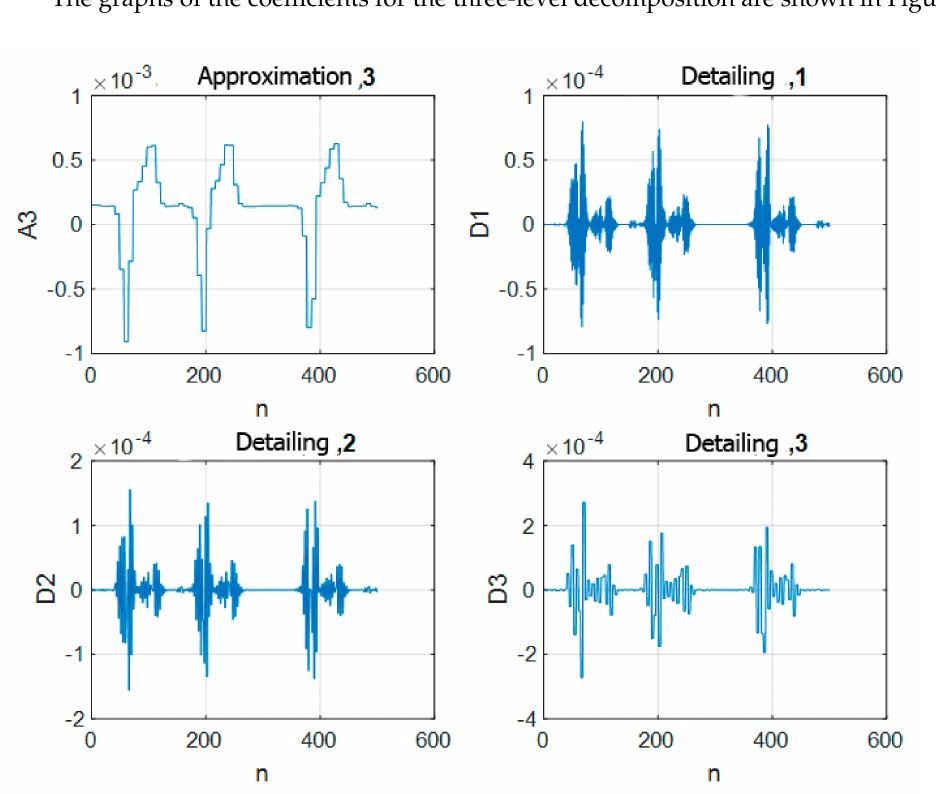
Figure 3. Graphs of coefficients of three-level approximation and